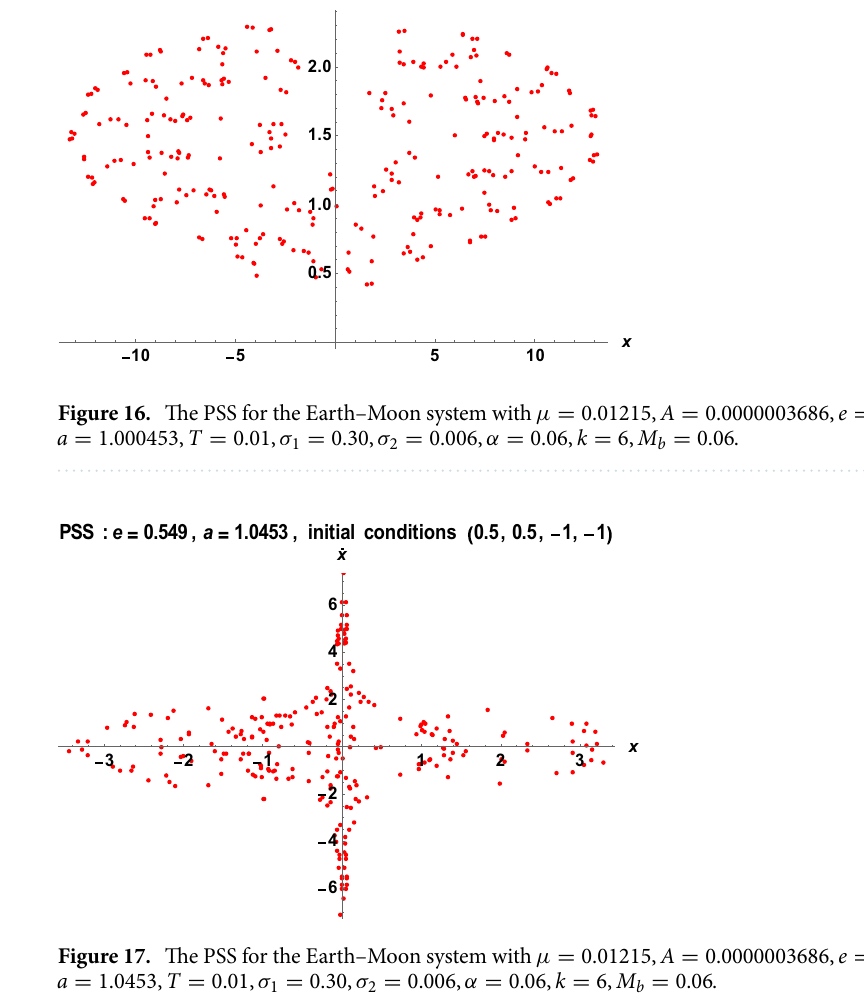
greater than zero. The numerical data of Tables 2 and 3 are used to demonstrate the zero velocity curves (ZVC) for the problem under study. As observed in Figs. 3 and 4, when the Albedo effects of both primaries, triaxiality of the smaller primary, and the potential due to the belt of the system increase with an increase in the Jacobian constant C , the two smaller obits merged to form a smaller region in between the two major regions resulting to three isolated possible regions. The movements of the primary regions, as observed in Fig. 5 for the system under review, depend on the